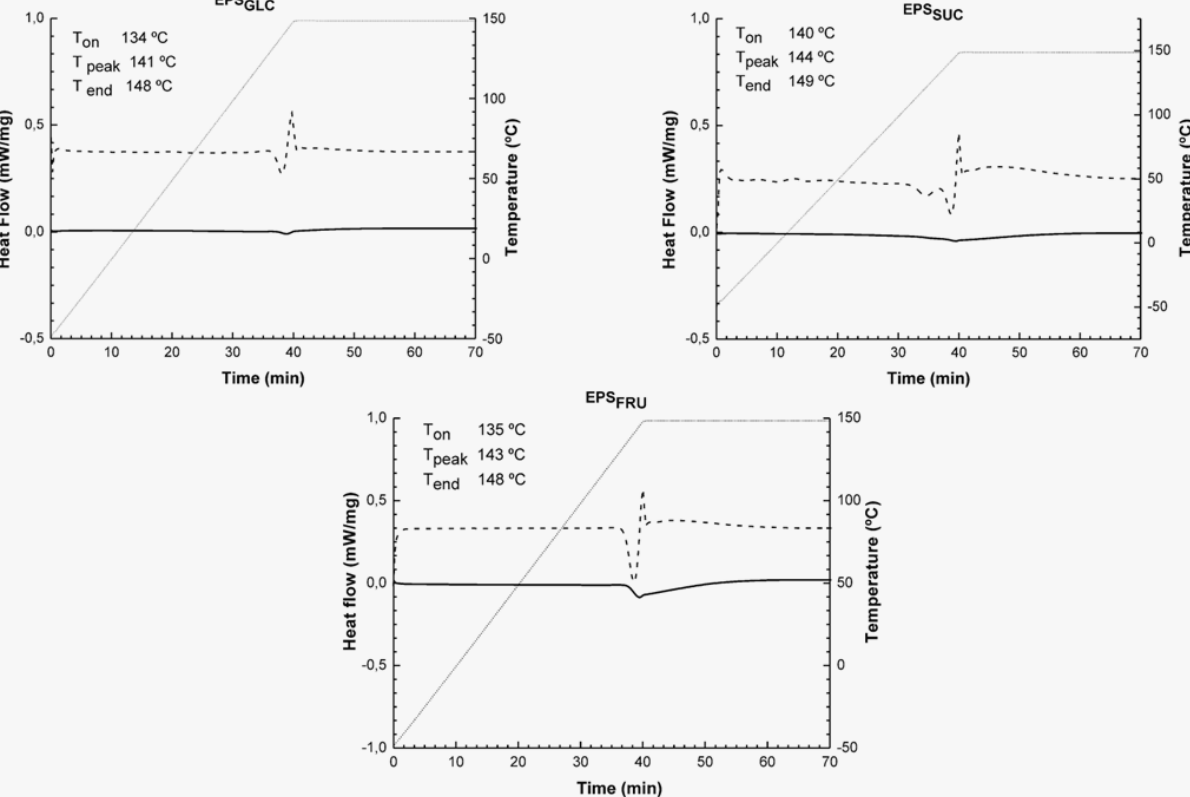
, EPS and GLC SUC